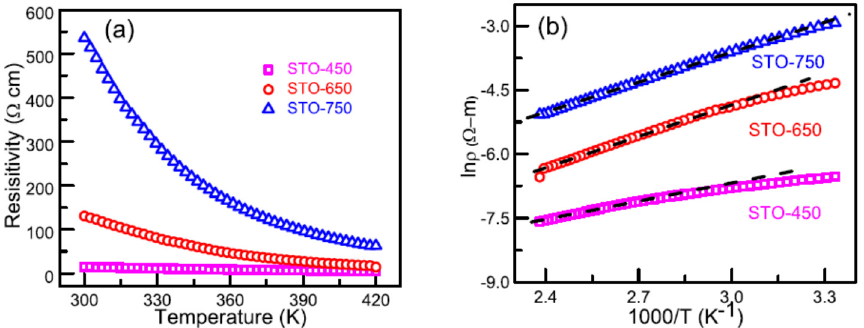
Figure 10. ( a ) Resistivity of STO thin films deposited at 450, 650, and 750 °C as a function of temperature, and ( b ) ln( ρ ) vs. 1/T of STO-450, STO-650, and STO-750 films, respectively. The dashed black line represents the linear fit. Reproduced with permission from [110], © 2020, Elsevier B.V.